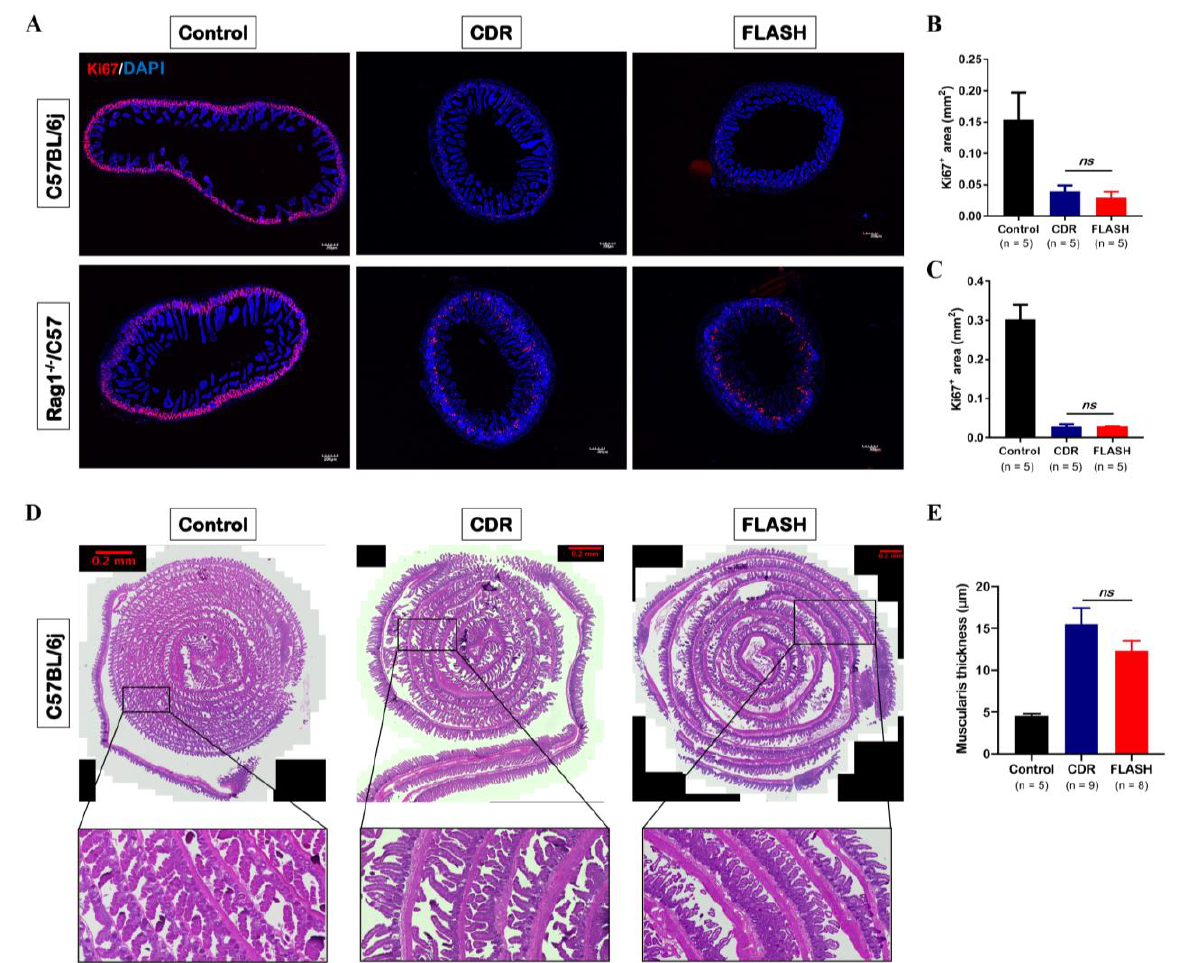
Figure 2. ( A ) Ki67 immunofluorescence staining images of intestinal tissues in C57BL/6j and Rag1 −/− /C57 mice. ( B ) Quantification of the Ki67-positive area in C57BL/6j mice. ( C ) Quantification of the Ki67-positive area in Rag1 −/− /C57 mice. ( D ) HE-stained images of a C57BL/6j mouse intestinal roll. ( E ) Quantification of muscularis externa thickness. ns, not significant.